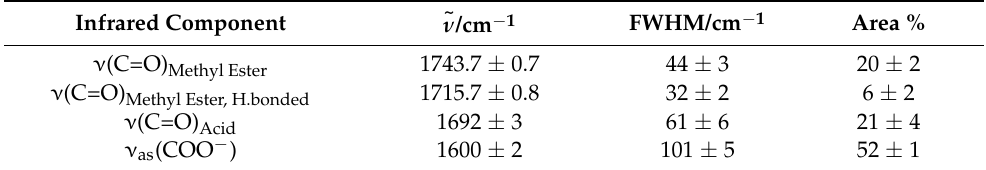
Table 1. Computed maximum ( (cid:101) ν , cm − 1 ), full width at half maximum (FWHM, cm − 1 ), relative area (A, %) and assignment of the bands obtained by decomposition into a sum of Gaussian components of the 1750–1500 cm − 1